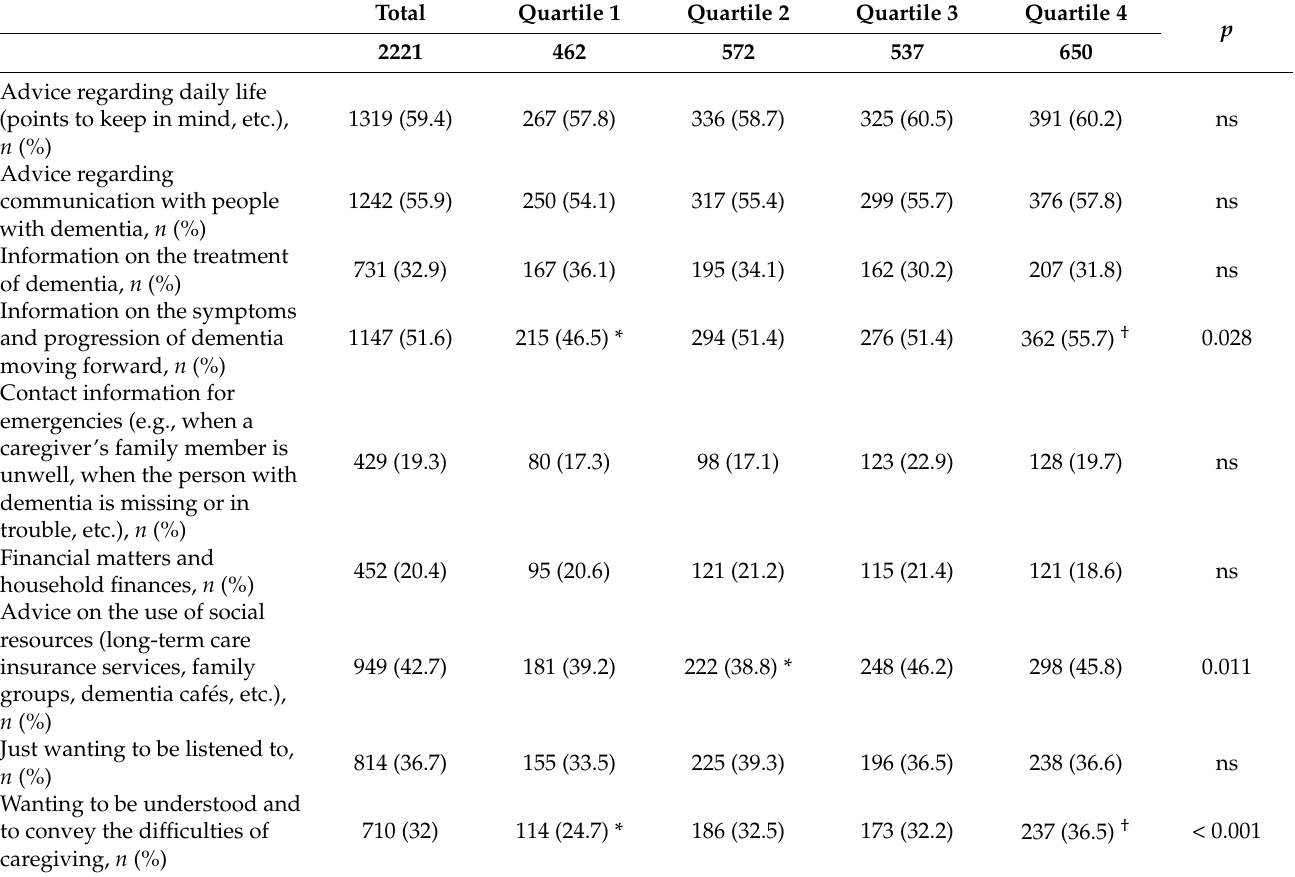
Table 5. Matters family caregivers were looking for from the persons they consulted.